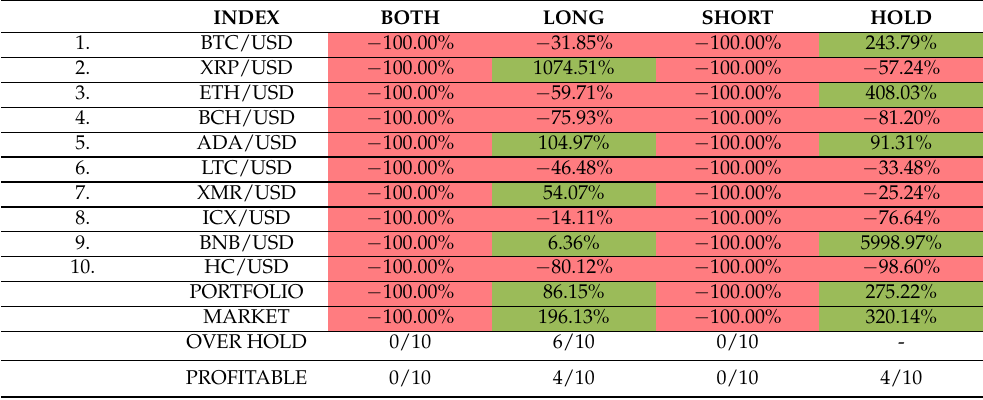
Table 5. The results of the strategy from the second experiment for portfolio and examined cryptocur- rencies. Green indicates positive returns, and red indicates negative